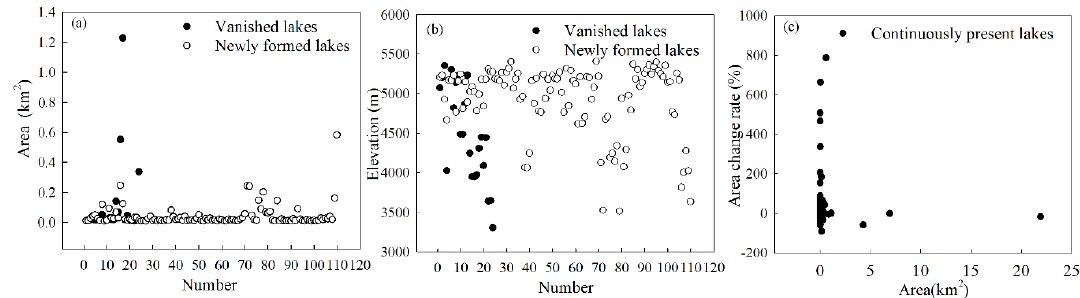
Figure 6. Distributions of ( a ) area and ( b ) elevation for the newly formed and vanished glacial lakes and ( c ) the area changes of glacial lakes that persisted throughout the study period.